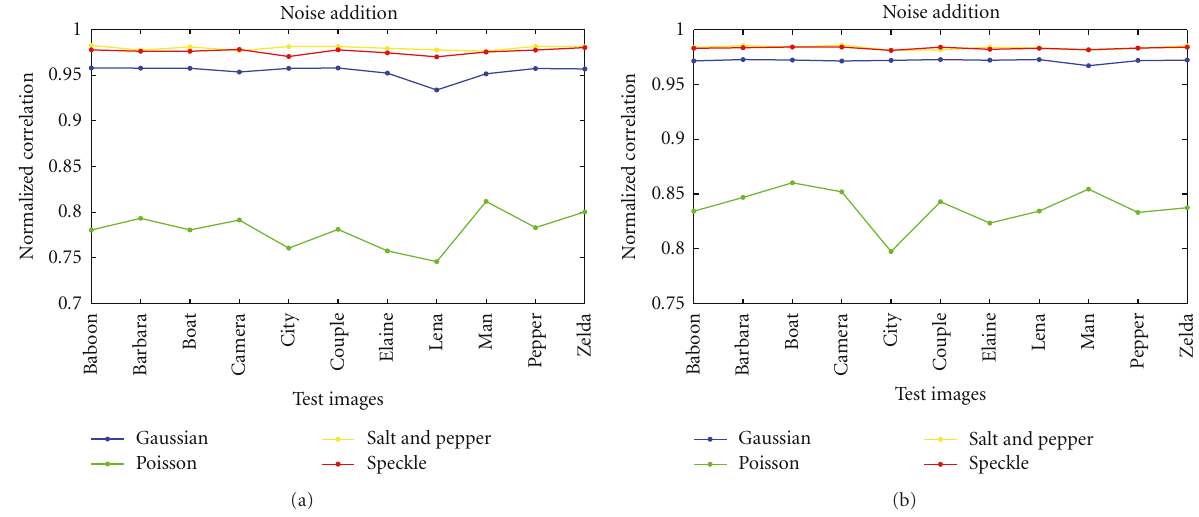
Figure 13: Normalized correlation results of di ff erent test images under noise attacks (a) embedding the watermark in the highest frequency subband of the host image (b) embedding the watermark in the 16th directional